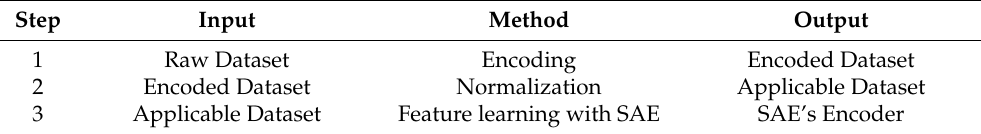
Table 6. The Preprocessing Module at Flow-level.